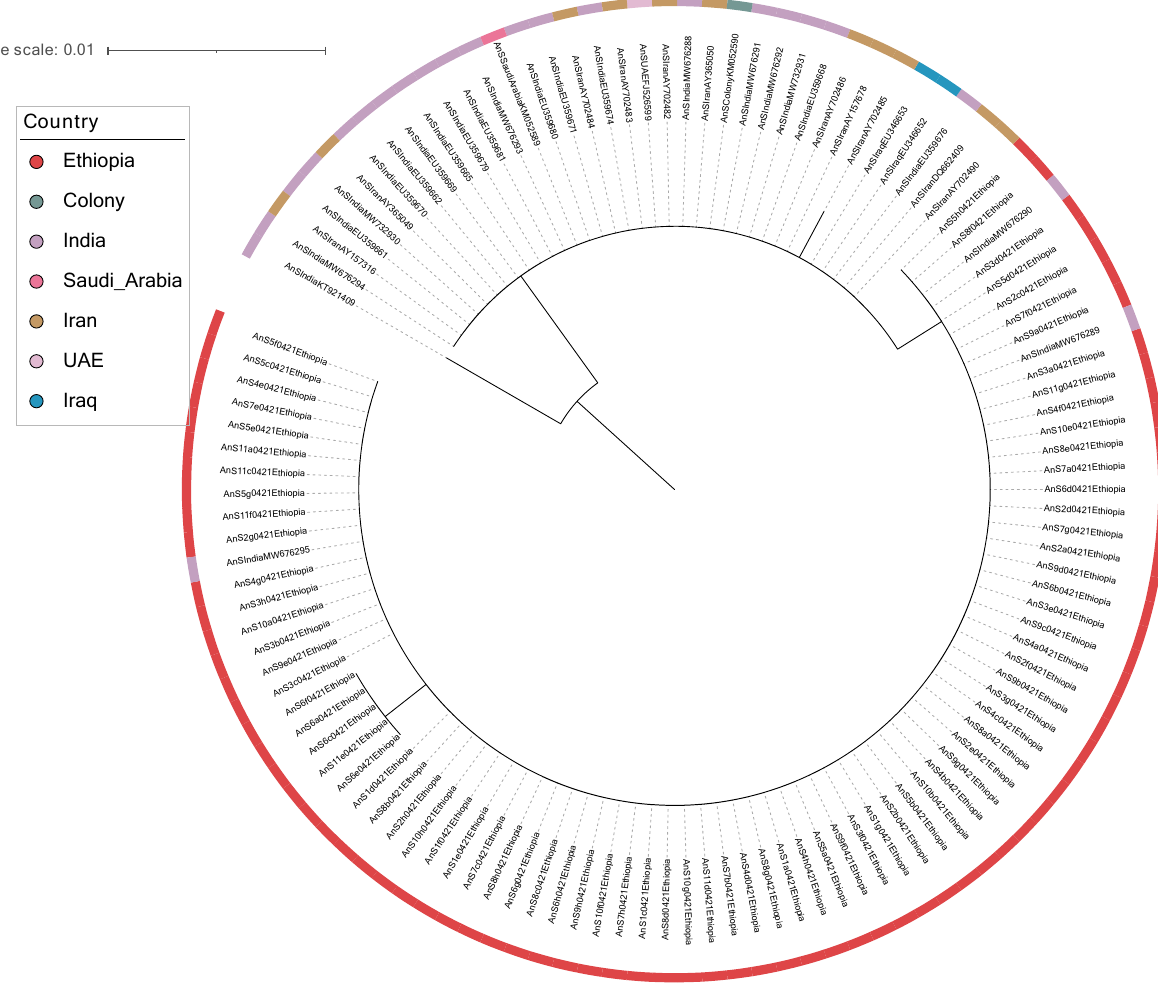
Figure 1. Neighbourhood joining tree constructed using ITS2 gene sequences generated from this study, alongside publicly available sequence data. The tree was built using the maximum-likelihood method assuming GTR model of nucleotide substitution, with the gamma model of heterogeneity rate. This tree was generated using RAxML, and visualised with iTOL 65,66